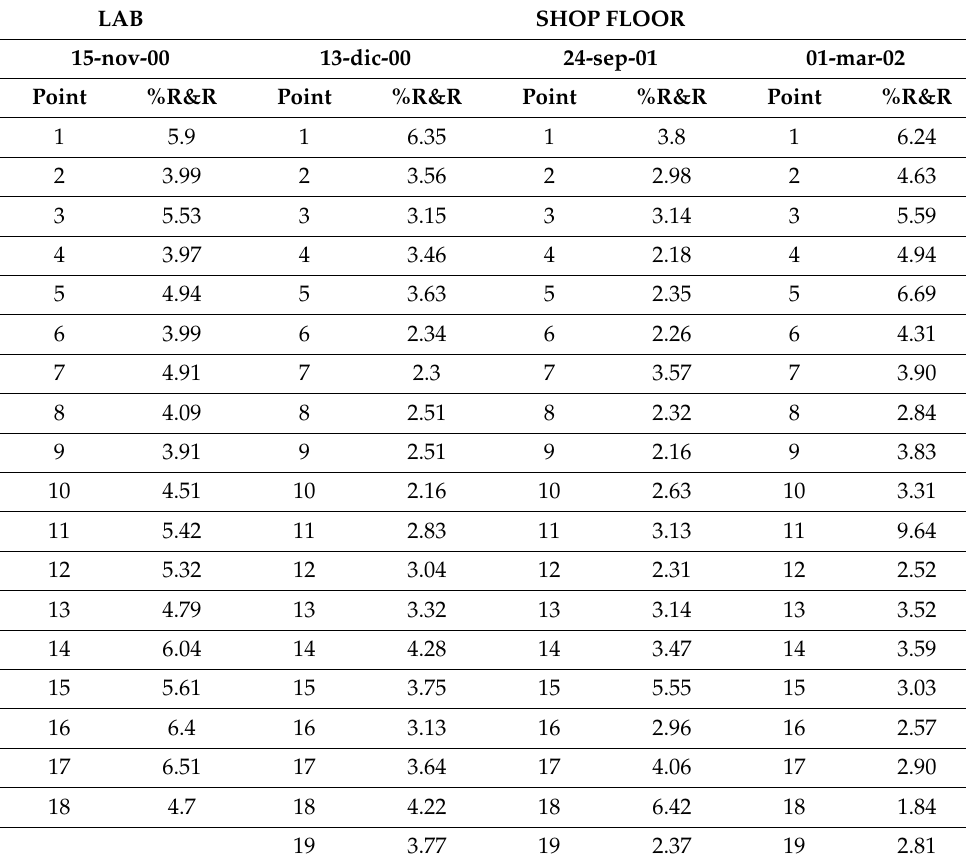
Table 2. In-line measuring machine Gage repeatability and reproducibility (R&R) results. The results of left hand columns correspond to the last test performed in the lab prior to shipping. The second tests was performed prior to the first run on shop floor. A measurement point was added between these two